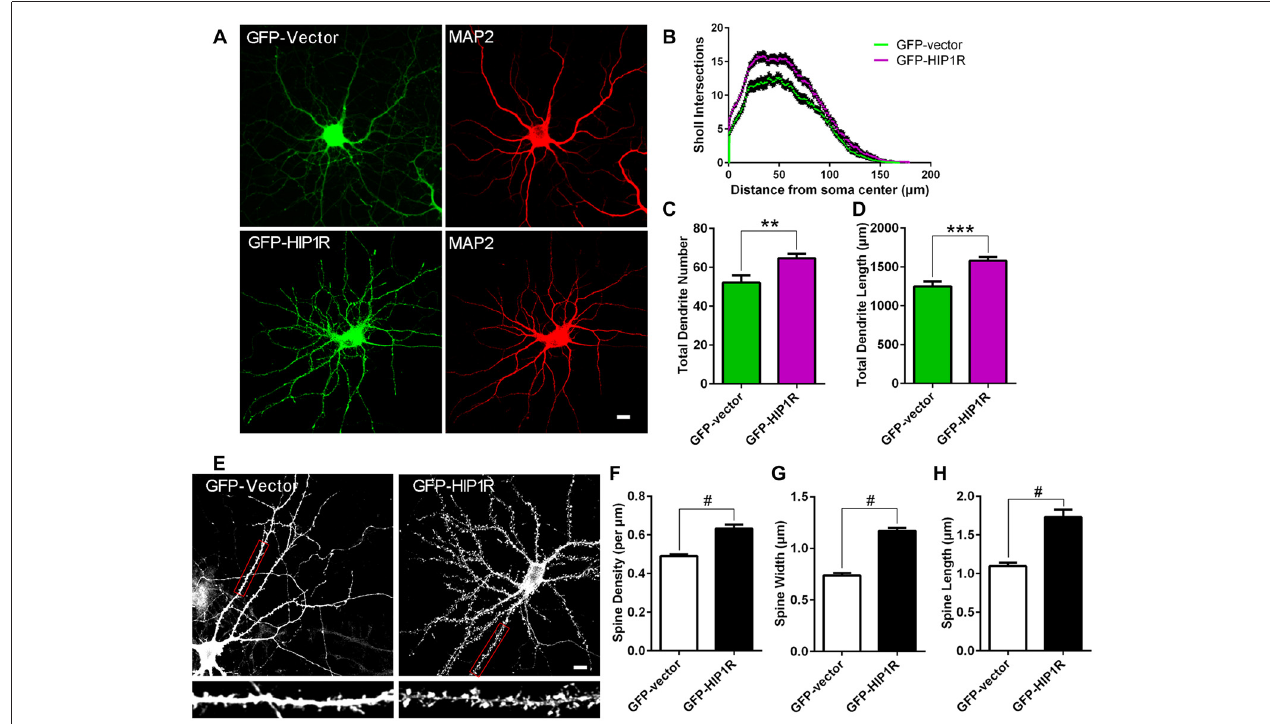
FIGURE 3 | Over-expression of HIP1R enhances dendritic growth and spine formation. (A–D) Cultured hippocampal neurons were transfected at DIV6 with GFP-HIP1R or GFP-expressing vectors. Images of the transfected neurons at DIV12 immunostained with anti-MAP2 were used for counting dendrites. Scale bar = 10 µ m (A) Sholl analysis indicated an increased complexity of dendrites in HIP1R over-expressed neurons (GFP-HIP1R) compared to the control (GFP-Vector) (B) . Quantitative data showed that both total dendrite number and total dendritic length were significantly increased in HIP1R over-expressed neurons compared to the control; 64.70 ± 2.326, n = 43 vs. 52.17 ± 3.66, n = 42 (C) and 1518.42 ± 45.80 µ m, n = 43 vs. 1249.72 ± 65.02 µ m, n = 42 (D) , respectively. (E–H) Images of the transfected neurons at DIV21 visualized by anti-GFP immunostaining were used for analyzing dendritic spines by MetaMorph software. Scale bar = 10 µ m (E) . Quantitative data revealed that spine density, width and length were all increased in HIP1R over-expressed neurons (GFP-HIP1R) compared to the control (GFP-Vector), with spine number per µ m: 0.63 ± 0.02 n = 48 vs. 0.49 ± 0.01 n = 48 (F) , spine width: 1.17 ± 0.03 µ m, n = 61 vs. 0.74 ± 0.03 µ m, n = 61 (G) ,